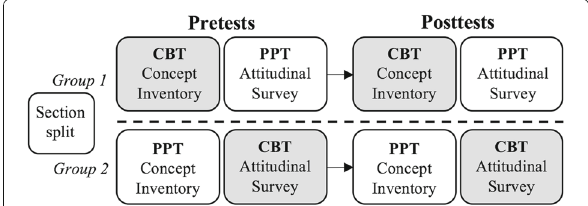
Fig. 1 Student groupings for RBA assignments using stratified random sampling. Each student takes one assessment online using LASSO and one in-class on paper at the beginning and again at the end of the